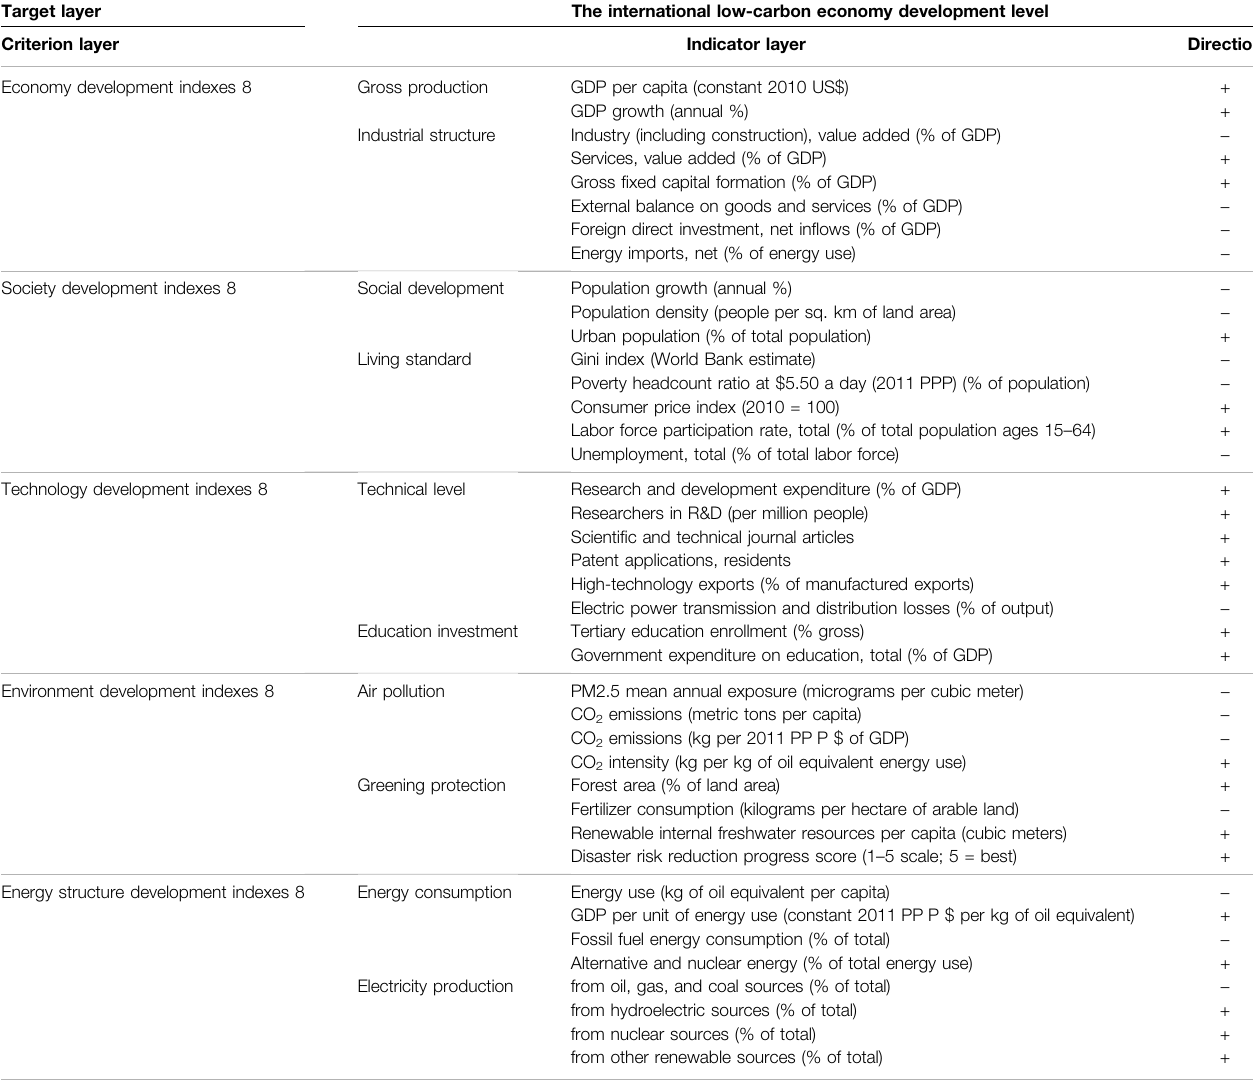
TABLE 1 | The evaluation index system of international low-carbon economy